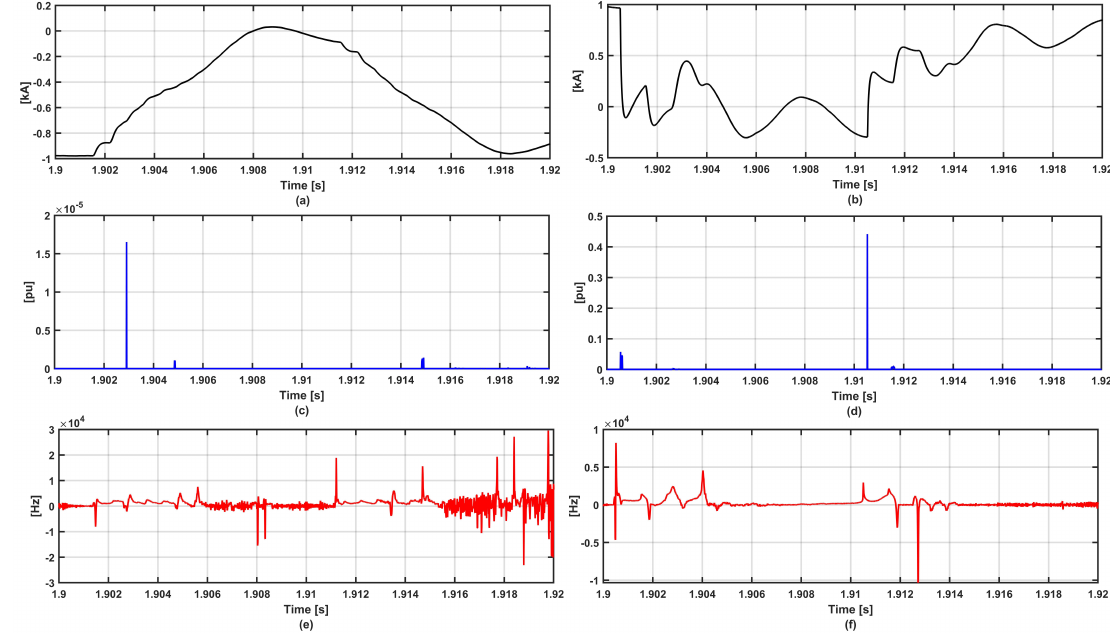
Figure 7. Simulation results for fault III. ( a ): RP3 current ( b ): RP4 ( c ): Instant amplitude for RP3 ( d